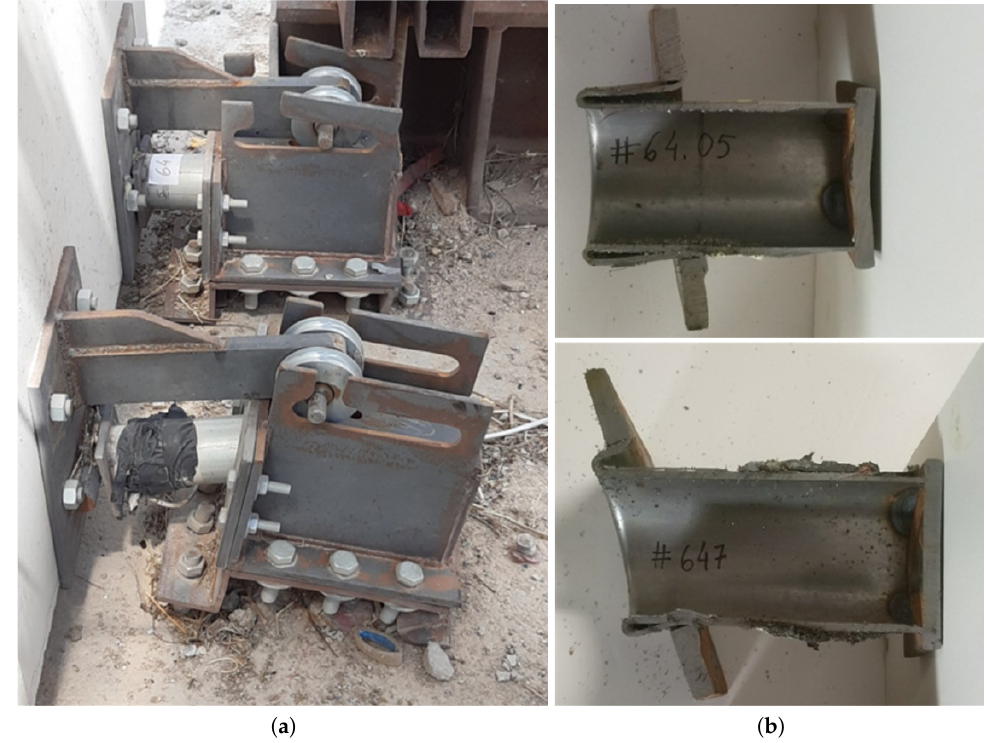
Figure 12. Sample panel 2B.( a ) General view of anchor deformation after blast for connectors #64.05 and #647. ( b ) Longitudinal section: final state of the inversion of φ 64 × 2.0 mm